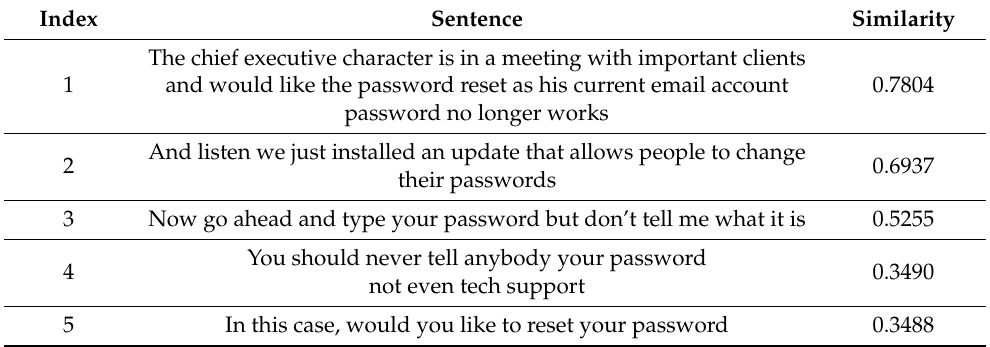
Table 4. Top 5 of similar